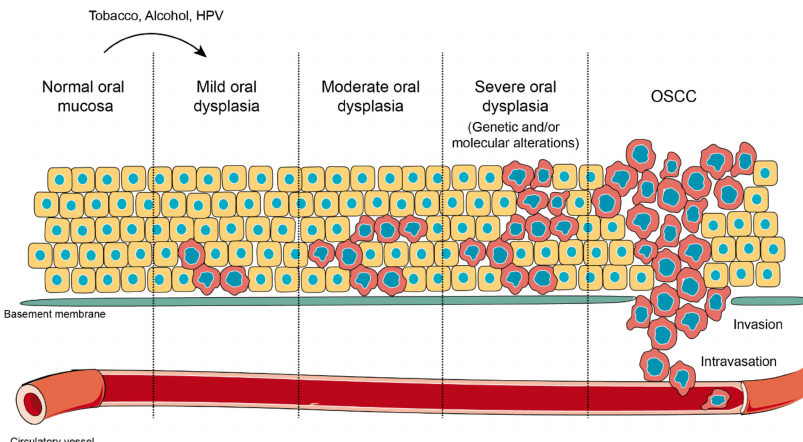
Figure 2. Oral carcinogenesis. Normal oral mucosa is a stratified layer of epithelial cells arranged over a basement membrane that separates epithelial cells from connective tissue and blood vessels. When oral mucosa is challenged with external stressors, such as tobacco, alcohol or human papilloma virus (HPV) infection, cells in the deepest layers undergo morphological alterations in shape and size. This novel state represents an adaptation response against a harmful stimulation, which is known as oral dysplasia. Oral dysplasia might be categorized as mild, moderate or severe, according with the extension of the lesion and the presence of molecular markers induced as result of the altered genetic expression. Oral dysplasia is considered the previous stage before oral squamous cell carcinoma (OSCC) and the strongest predictor of malignant transformation to cancer. During OSCC, massive phenotypic changes a ff ect all epithelial layers, and it is extended over the tissue border, with ruptures of the basement membrane, in a process that allows the invasion of the connective tissue and incorporation into blood vessels